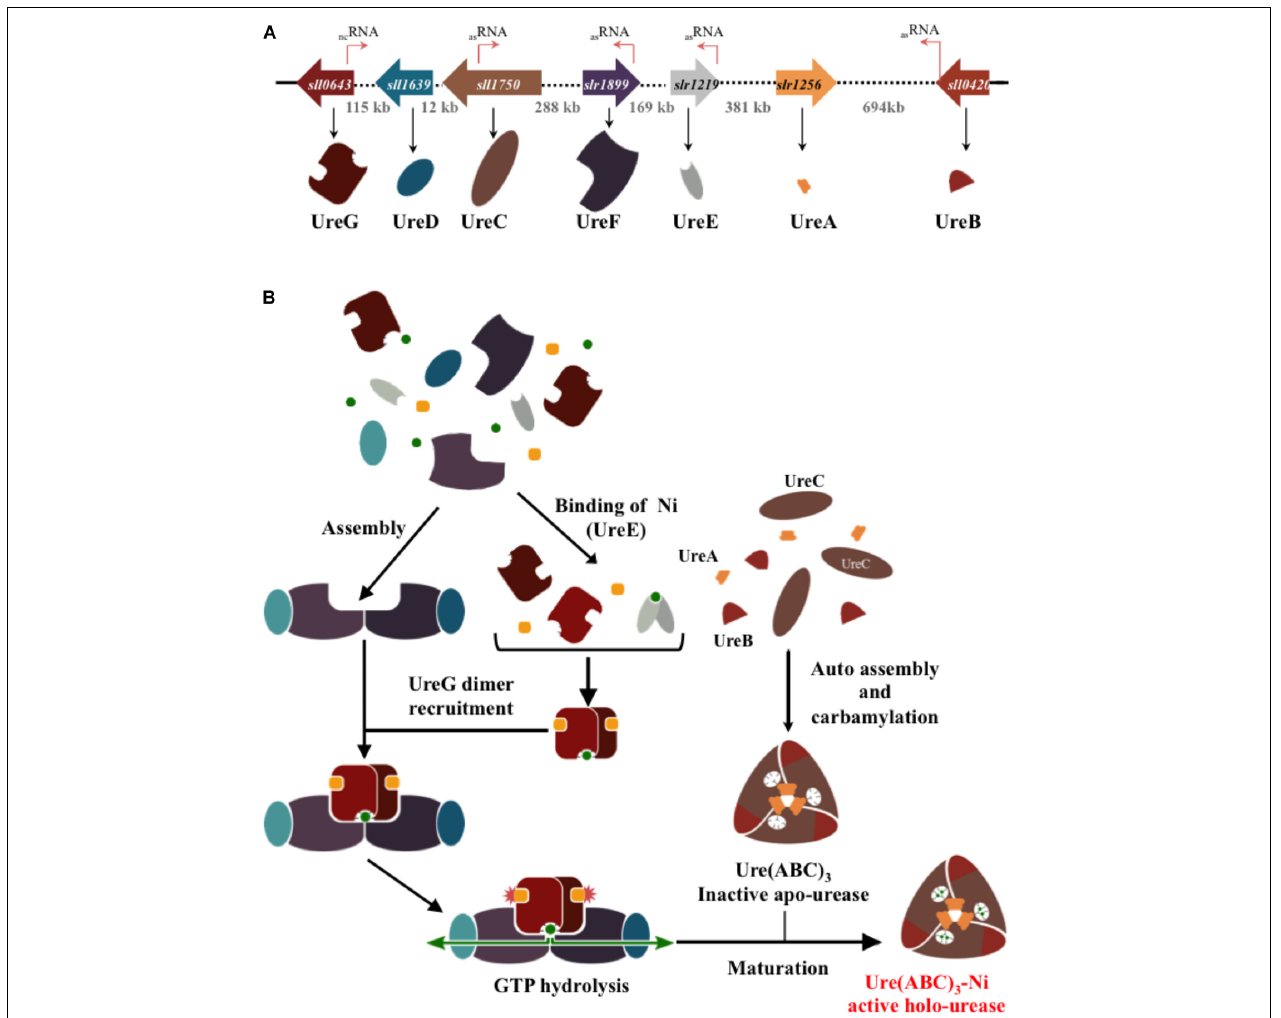
FIGURE 1 | Schematic representation of the genes and proteins involved in the formation of the urease in the best-studied cyanobacterium Synechocystis PCC6803. (A) The genes encoding the urease catalytic subunits (UreABC) and the chaperones (UreDEFG) involved in its assembly are represented by large colored arrows indicating the direction of their transcription. The dotted lines and the numbers indicate the length of DNA (in Kb) separating the urease genes. The thin orange arrows stand for the small RNA (see cyanobase) of as yet unknow function. (B) Steps of the urease assembly and maturation process. The nickel ion and the guanoside-5 (cid:48) -triphosphate (GTP) are represented by green dots and orange squares,